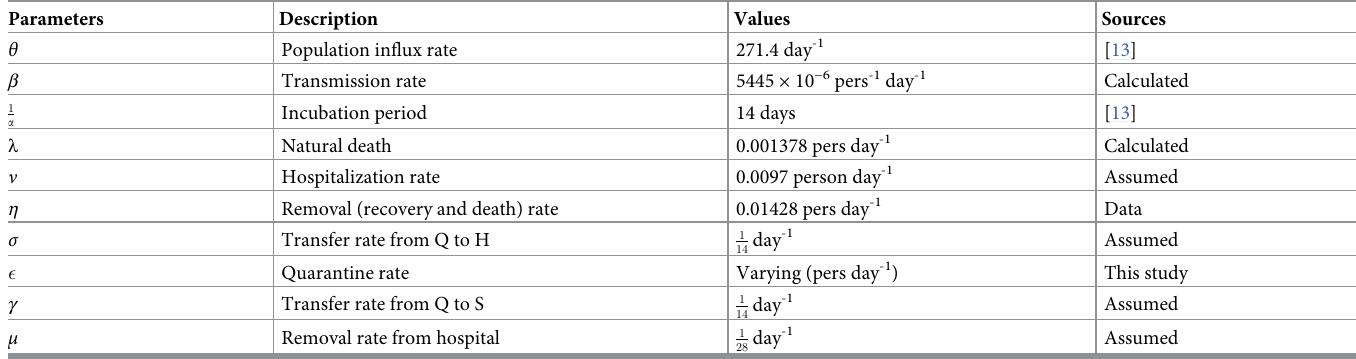
Table 1. Parameters used in the